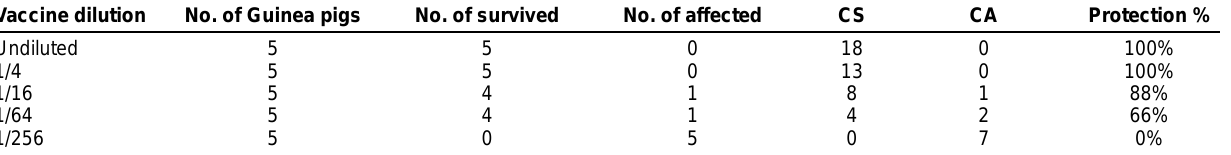
Table-6. GPPD of trivalent FMD vaccine (type O panAsia-2, A IranO5 and SAT2/EGY/2012) 50 Vaccine